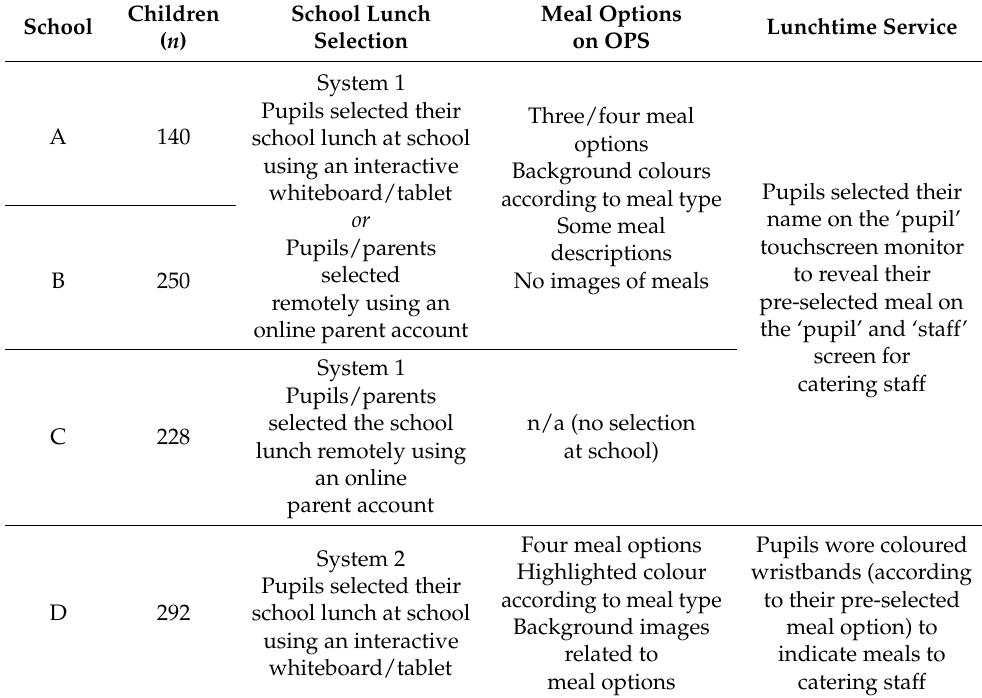
Table 1. Direct observation at four primary schools offering school lunch selections by online pre- order systems